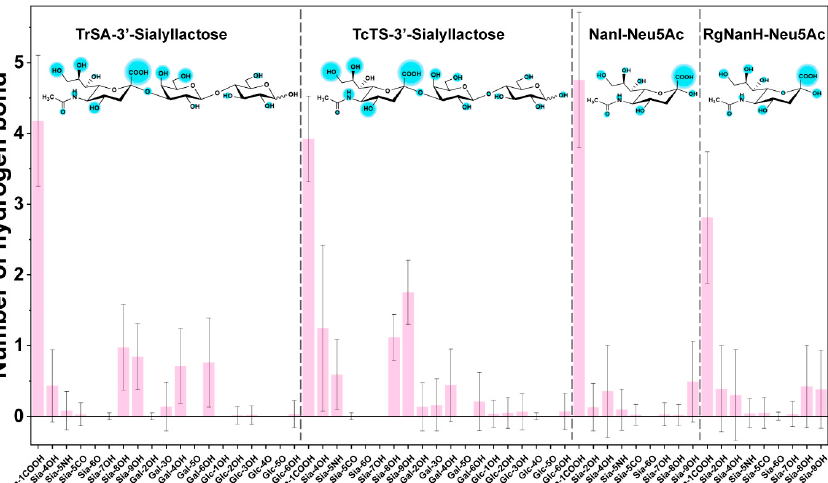
Figure 4. Hydrogen bonding interaction between the substrate and GH33 sialidases. The hydrogen bonds were analyzed based on the MD simulations. The sizes of the cyan cycles shown in the chemical structures of the substrate represent the strength of the hydrogen bonding interactions. Sia ‐ 1COOH, the carboxyl group linking to C1 of sialic acid; Sia ‐ 4OH, the hydroxyl group linking to C4 of sialic acid; Sia ‐ 5NH, the acetyl amino group linking to C5 of sialic acid; Sia ‐ 5CO, the acetyl amino group linking to C5 of sialic acid; Gal ‐ 2OH, the hydroxyl group linking to C2 of galactose; and Glc ‐ 1OH, the hydroxyl group linking to C1 of glucose.